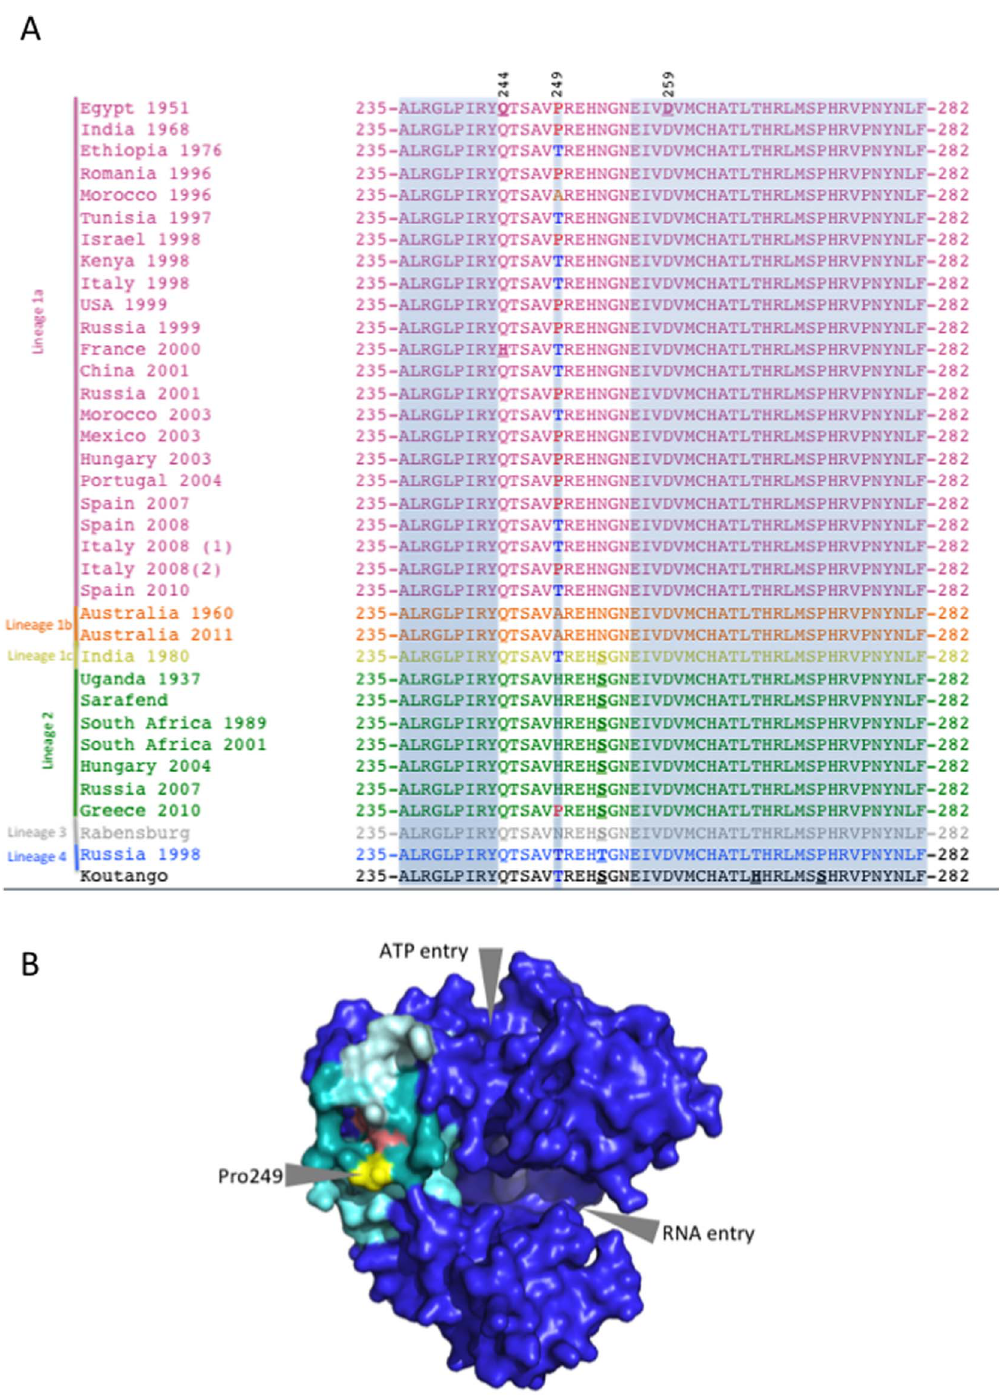
Figure 2. Sequence alignment of NS3-235–282 and helicase structure. (A) Alignment of 36 WNV strains between NS3 aa positions 235–282. The NS3-249 locus is indicated and the amino acid identities colored according to the same color scheme as depicted in panels A and B. Shaded areas correspond to aa 235–243 and aa 256–282, and emboldened and underlined text highlight genetic differences as well as sites of compensatory mutations (NS3-244 and NS3-259). Panel (B) Surface image depiction of the WNV helicase. Arrows depict RNA-entry site, ATP hydrolysis site and NS3- 249 (yellow). Other substitutions identified in this study (salmon) include Q244H just above Pro249 and D259E just behind Q244. The peptides surrounding Pro249 include amino acids 256–282 (light cyan), 243–254 (dark cyan) and 235–243 (medium cyan).